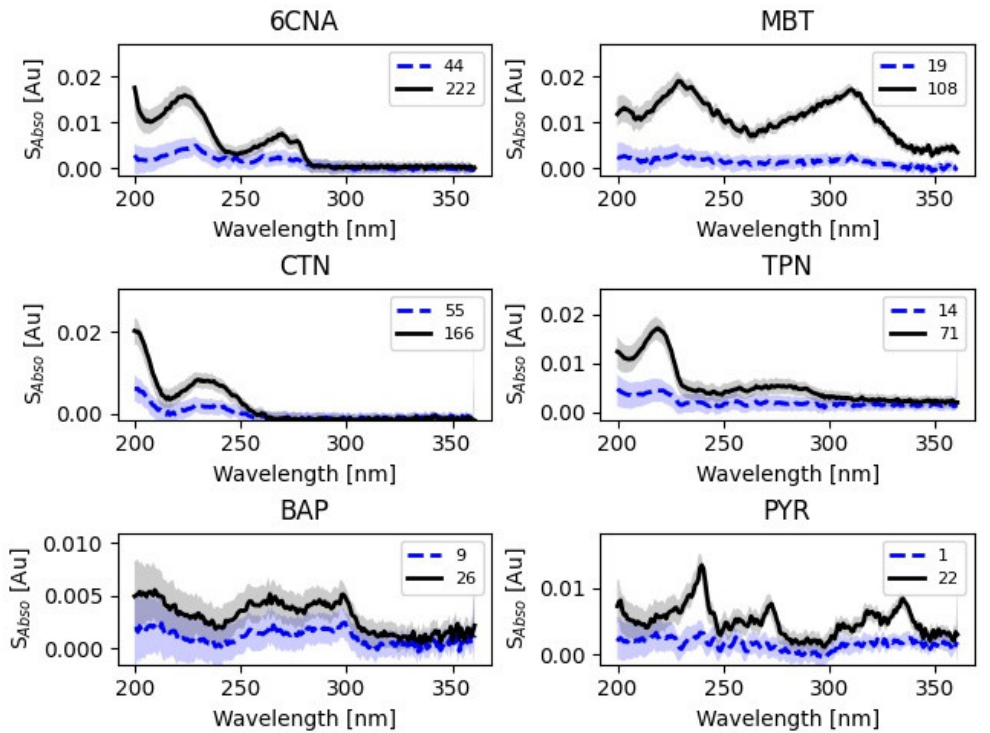
Figure 2. S Abso for the six substances spiked to the drinking water as described in Section 2.1 and for the high (black line) and the lowest (blue line) detectable concentrations (µg/L). Values of concentrations displayed in the legend are provided in µg/L. The uncertainty of ±σ of Δ Abso is overlayed.